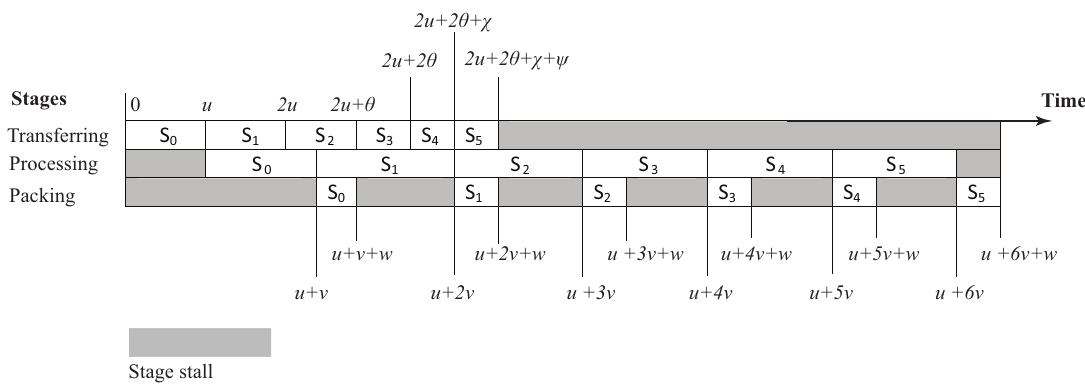
Figure 3. Pipelined scheduling, v > u > w